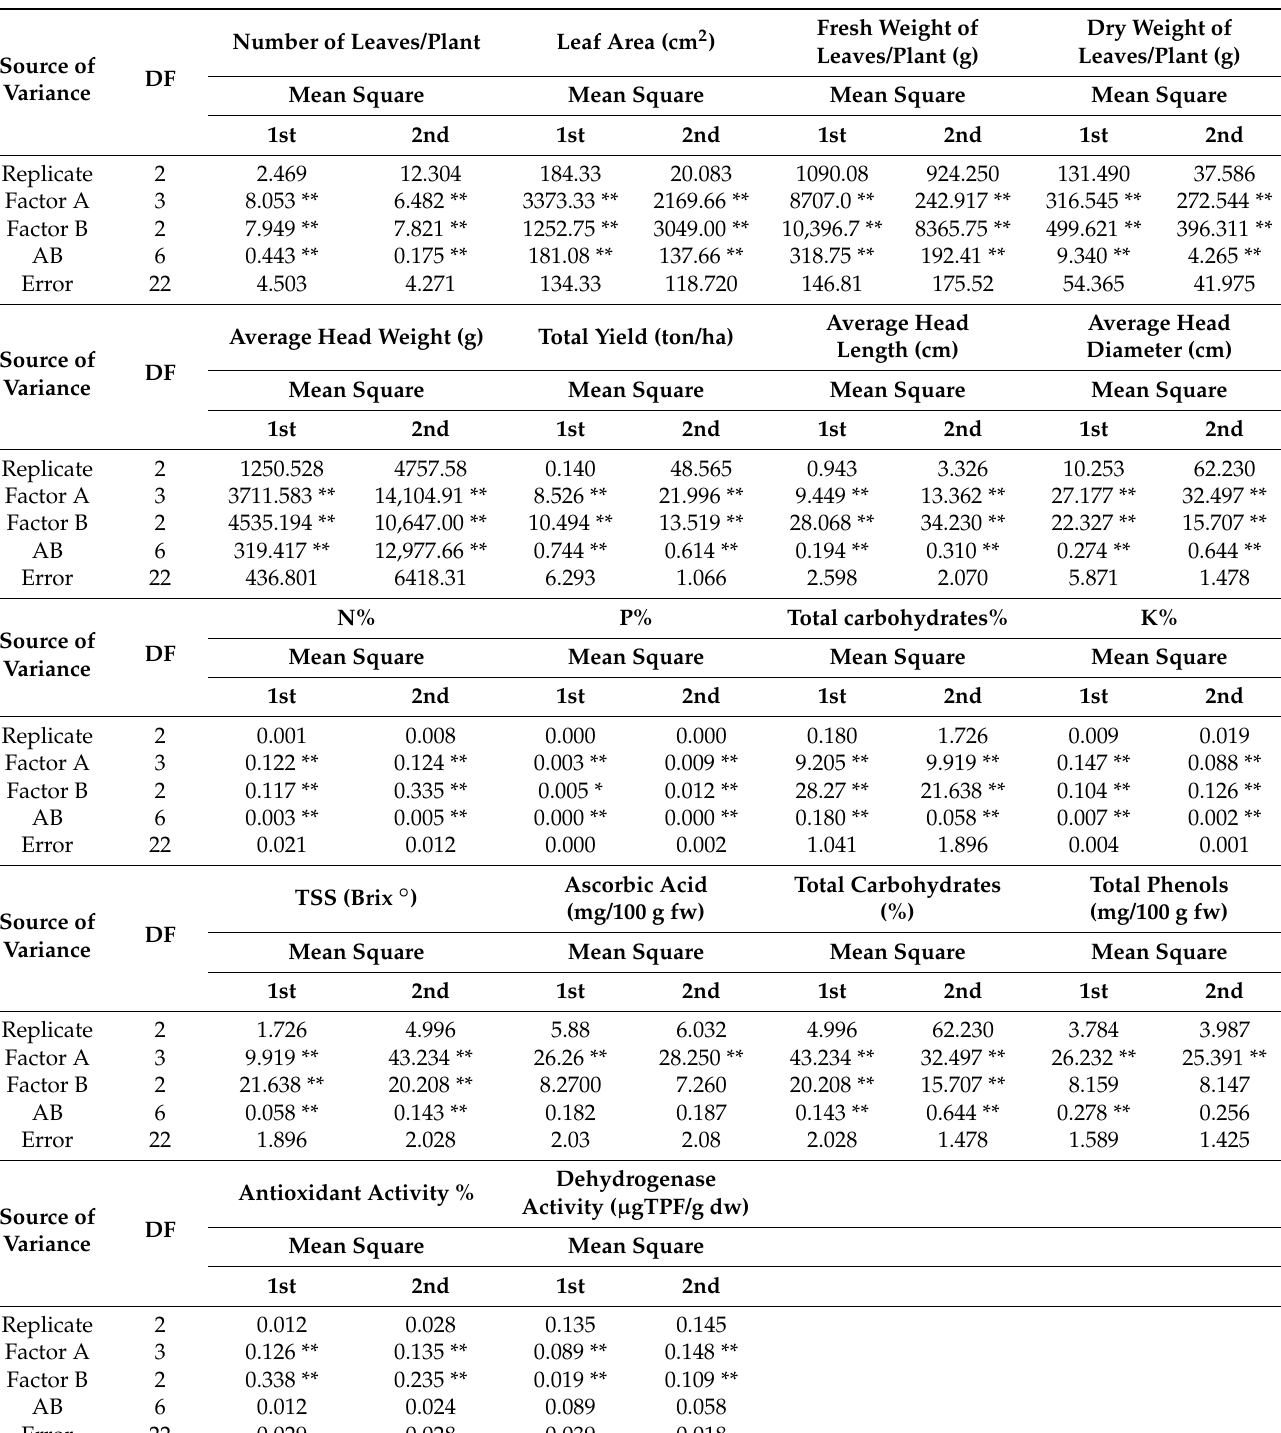
Table 4. The analysis of variance (ANOVA) results for the effect of phosphorus source (Factor A), bio-fertilizers application (Factor B) and their interaction (AB) on different parameters of broccoli plants during the 2018 (1st) and 2019 (2nd)